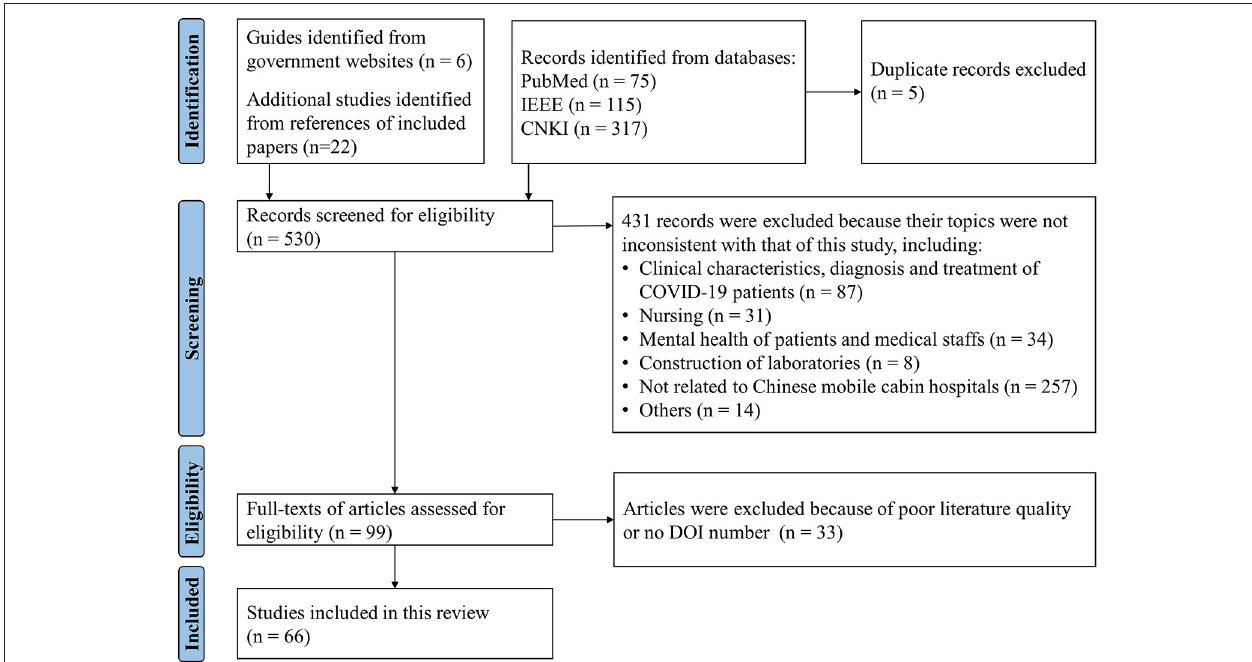
FIGURE 1 | PRISMA flow diagram illustrating the screening process for the literature included in this